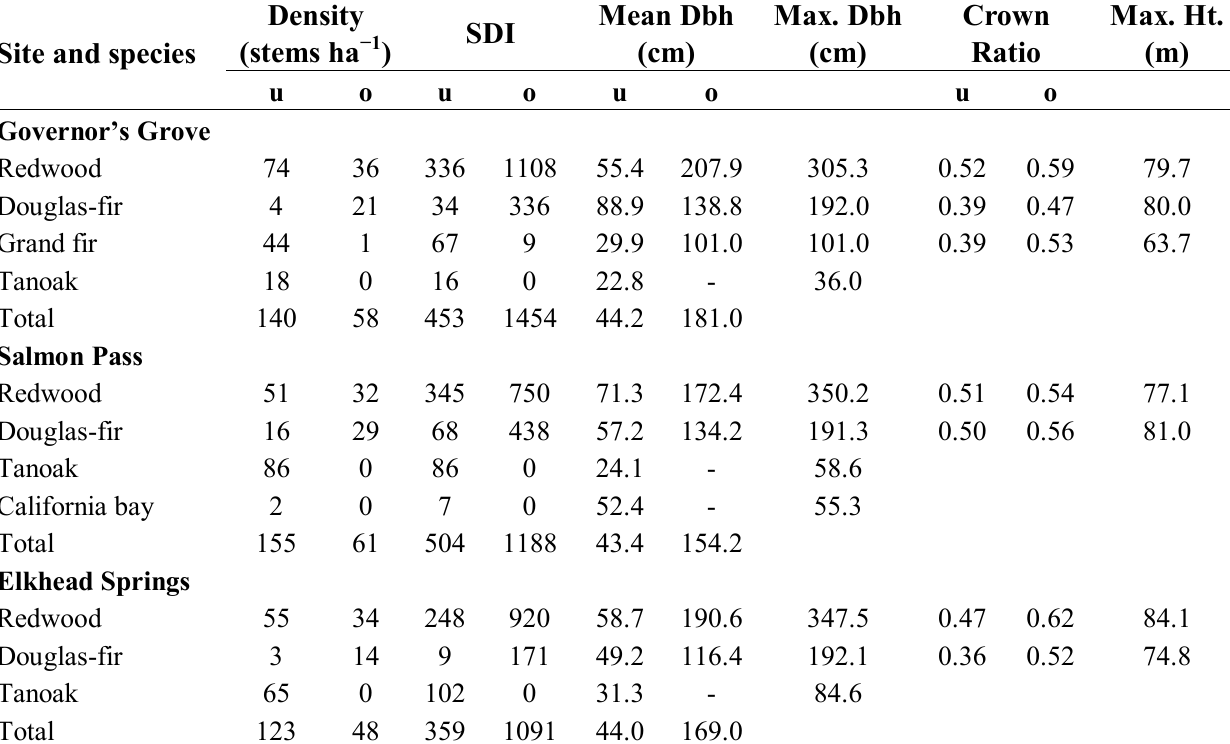
Table 2. Summary data for trees ≥15 cm dbh in three 1-ha plots in old-growth stands at Headwaters Forest Reserve, California. Data aggregated by crown class into understory (u, suppressed and intermediate) and overstory (o, dominant and codominant) groups. Height recorded for conifers